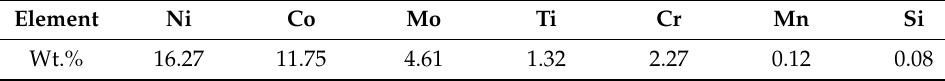
Figure 1. FE-SEM and EDS images of maraging stainless steel powder. Table 1. Chemical composition of the maraging stainless steel powder.